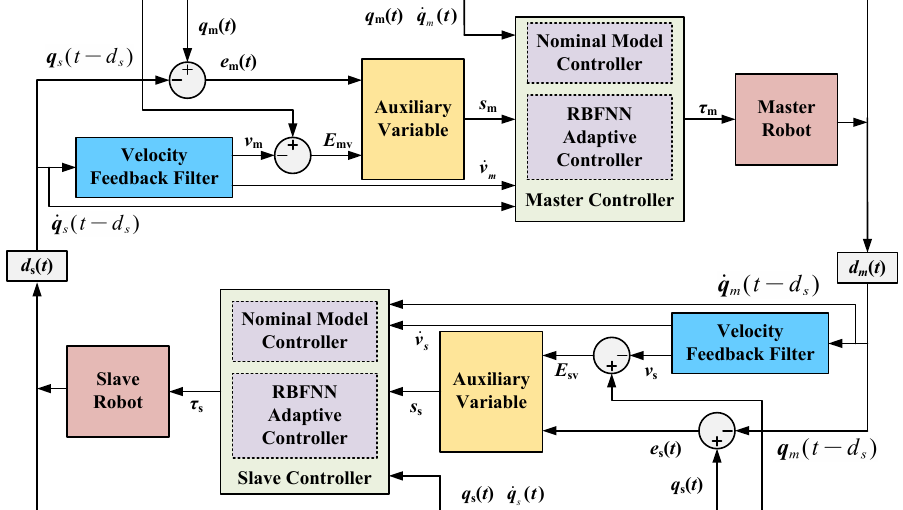
Figure 1. Proposed control